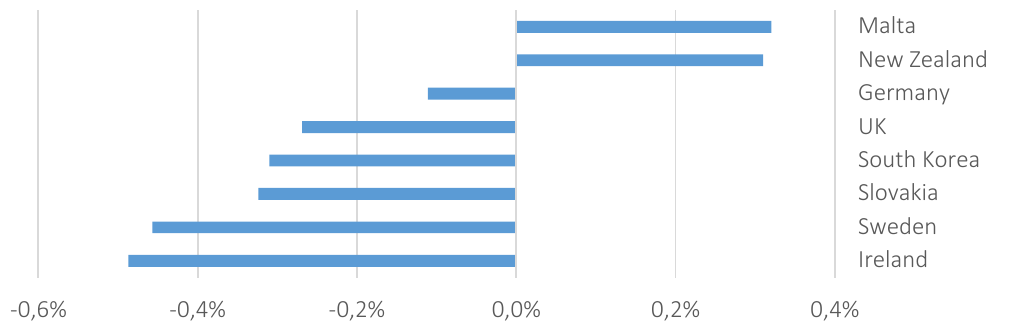
Figure 8. Estimated values of GDP gaps for the countries of the world